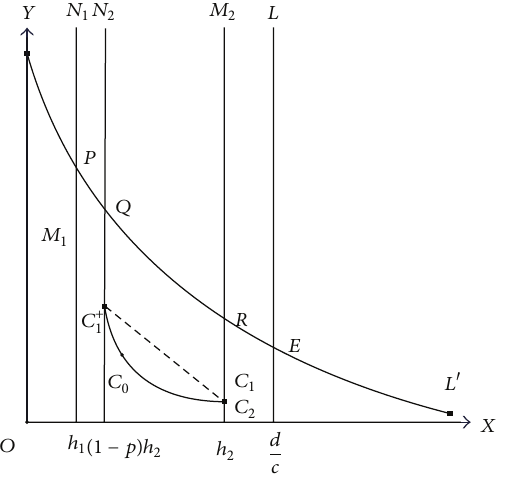
Figure 12: The orbit starting from the point 𝐶 0 (Case 2 in Section